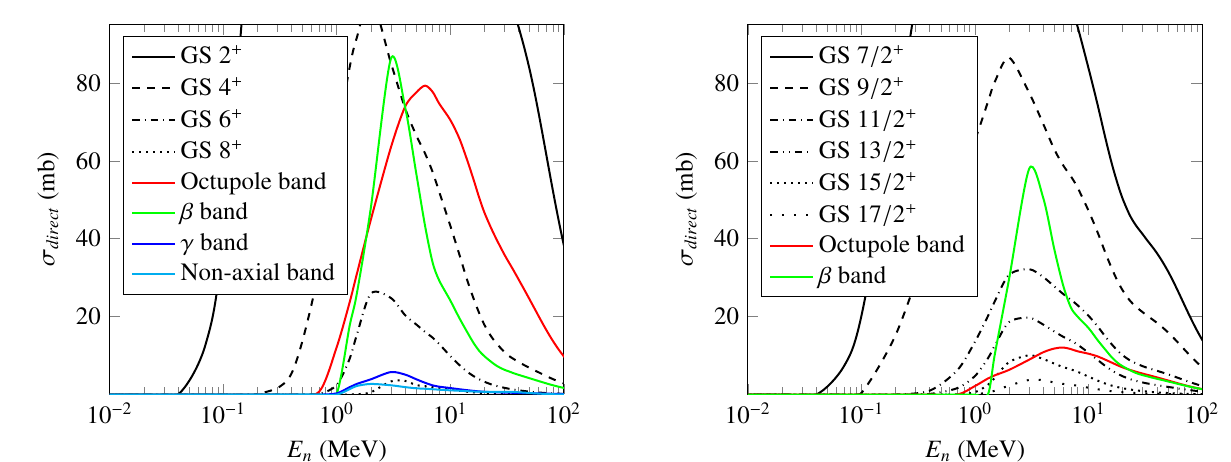
Figure 2. Calculated nonelastic cross sections (dashed) for neu- tron scattering on 238 U using three dispersive optical model po- tentials: RIPL 2408 – rigid-rotor GS band coupling [12–14], multiband coupling with fitted “e ff ective” deformations [17], and current model with SRM-derived multiband coupling. Derived experimental nonelastic neutron scattering cross sections from EXFOR [22–26] (black points) and Dietrich [27] (red points) are compared to calculations. Note that the direct inelastic cross sec- tions of the first two excited levels were also included as quasi- elastic cross sections to derive the plotted non-elastic cross sec- tion σ nonel . Calculated CN formation cross section using the (cid:31) new SRM model is shown as solid line for comparison. timated non-elastic cross sections by Dietrich [27] 2 . An